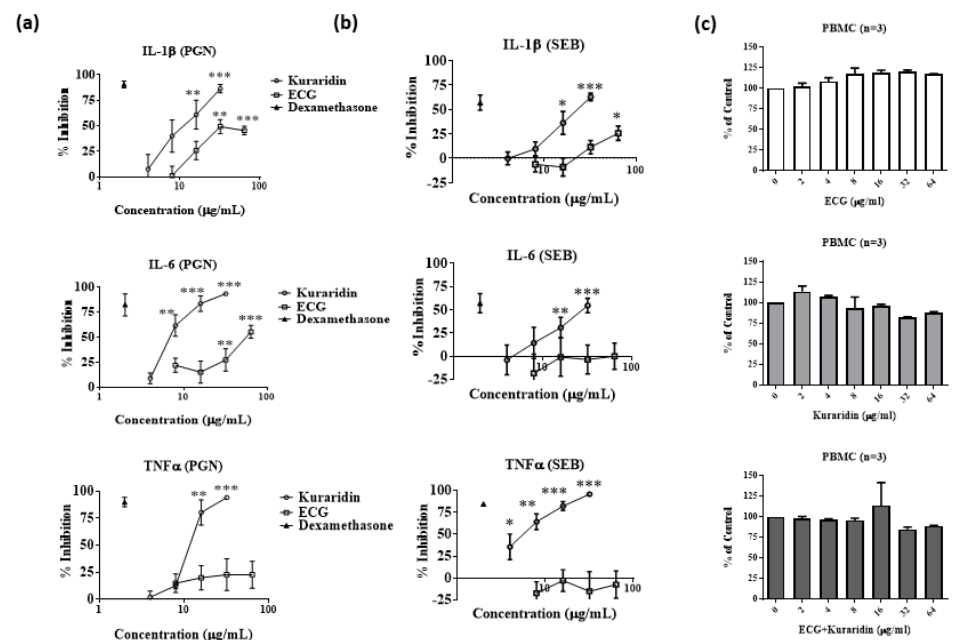
Figure 2. Inhibitory effects of epicatechin gallate (ECG) and kuraridin on inflammatory cytokines (IL-1 β , IL-6 and TNF α ) production and cytotoxicity of human peripheral blood mononuclear cells (PBMC) stimulated with ( a ) Peptidoglycan (PGN) and ( b ) Staphylococcal enterotoxin B (SEB) (n = 4). Dexamethasone at 1 µ g/mL was used as positive control to inhibit the production of inflammatory cytokines. PGN (0.1 µ g/mL) or SEB (10 µ g/mL) was used to stimulate the PBMC to produce cytokines. Kuraridin or ECG (4–64 µ g/mL) was added to the cells and the cell supernatant was collected for cytokine assays. ( c ) Cellular toxicity (XTT assay) of epicatechin gallate (ECG) and kuraridin on human peripheral blood mononuclear cells (PBMC) (n = 3). Significant results by comparing the drug treatment groups with the drug-free control are indicated (* p < 0.05; ** p < 0.01; *** p < 0.001). The cytotoxicity of the ECG and kuraridin on human PBMC was determined by sodium 3 (cid:48) -[1-(phenylaminocarbonyl)-3, 4-tetrazolium]-bis (4-methoxy-6- nitro) benzene sul- fonic acid hydrate (XTT) assay (Figure 2c). ECG (2–64 µ g/mL) and kuraridin (2–16 µ